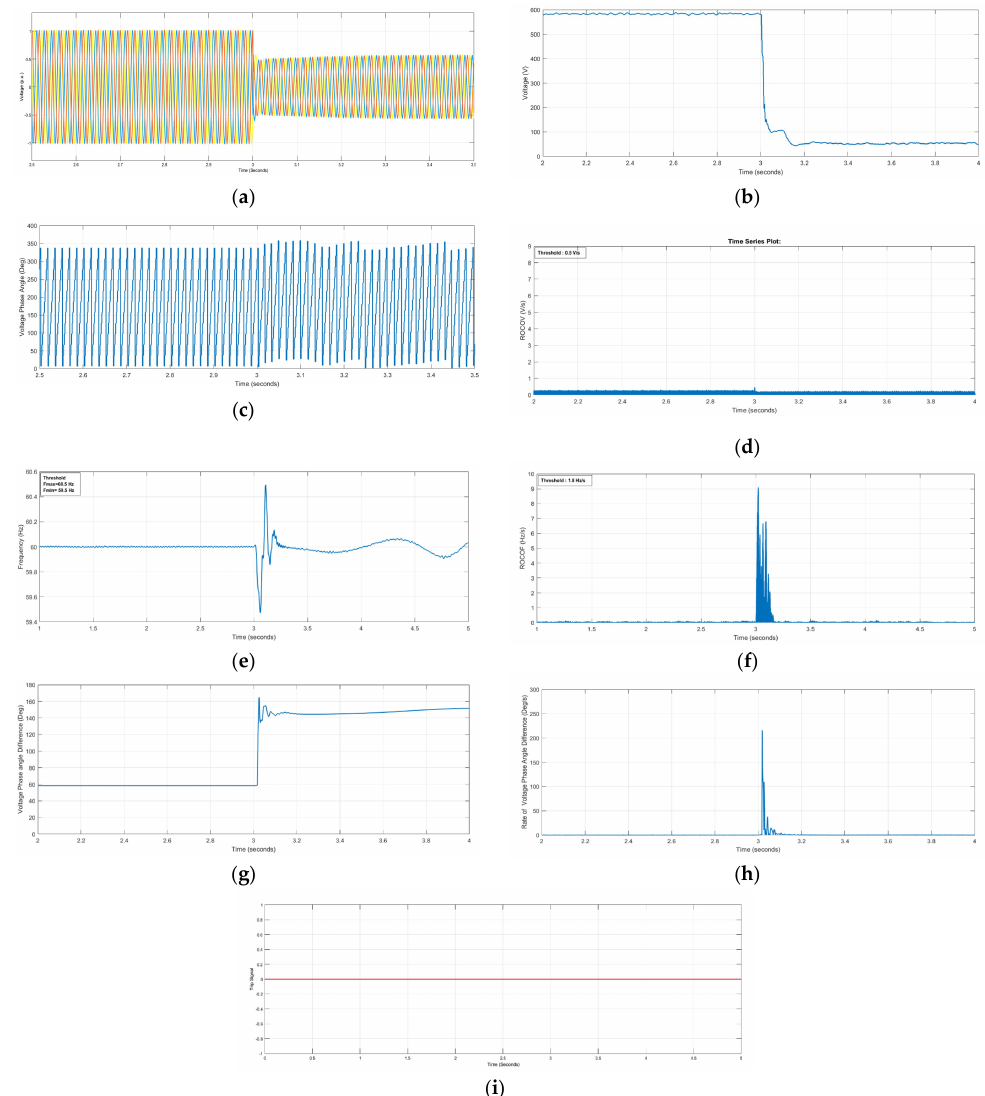
Figure 12. Results of case (iv) Non-islanding condition: short circuit fault. ( a ) Feeder voltage; ( b ) DG voltage magnitude; ( c ) DG voltage phase angle; ( d ) ROCOV relay; ( e ) frequency relay; ( f ) ROCOF relay; ( g ) Voltage phase angle difference; ( h ) Rate of change of voltage phase angle difference; ( i )Trip Signal.